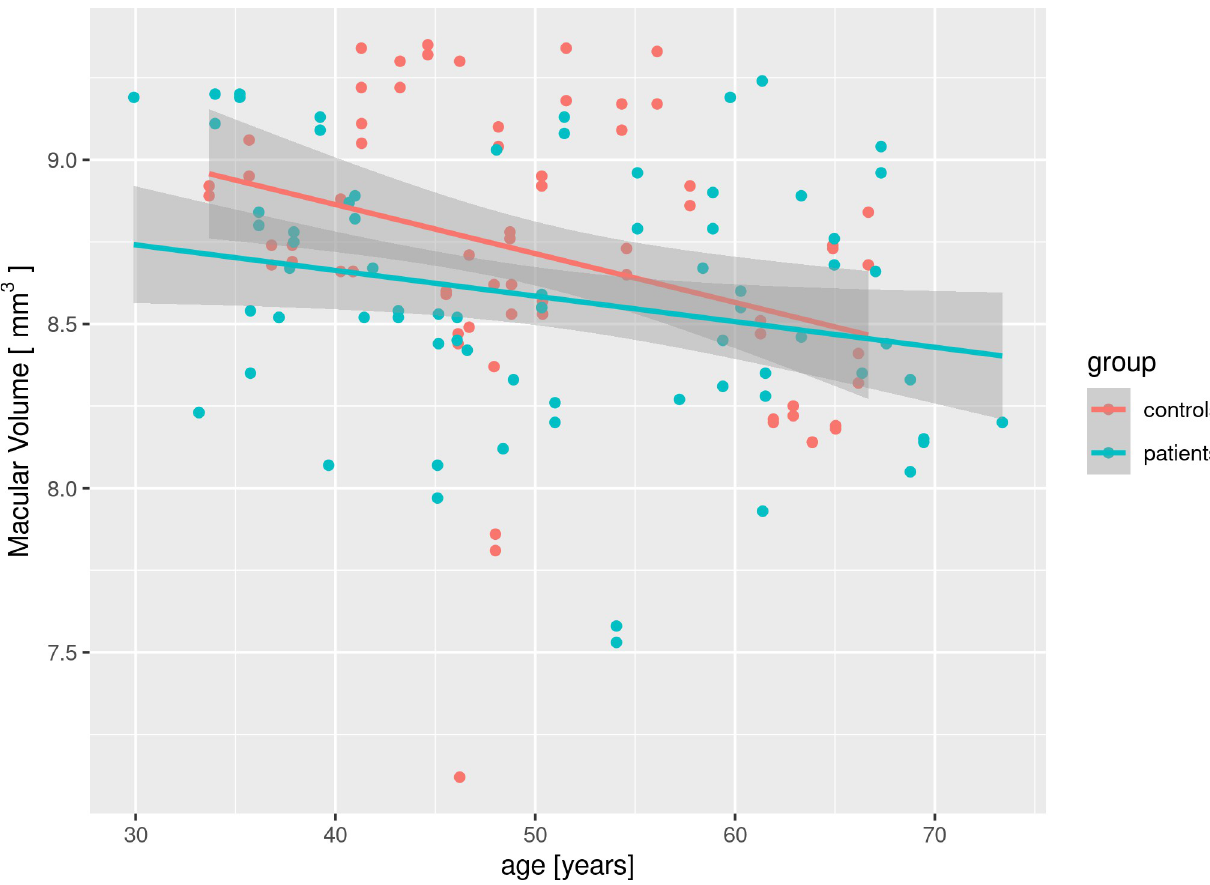
Fig 1. Scatter plot of macular volume vs. age in patient and control group. Note that the rate of macular volume loss with aging is steeper in the control group than in the patient group. The difference in slopes is not significant.